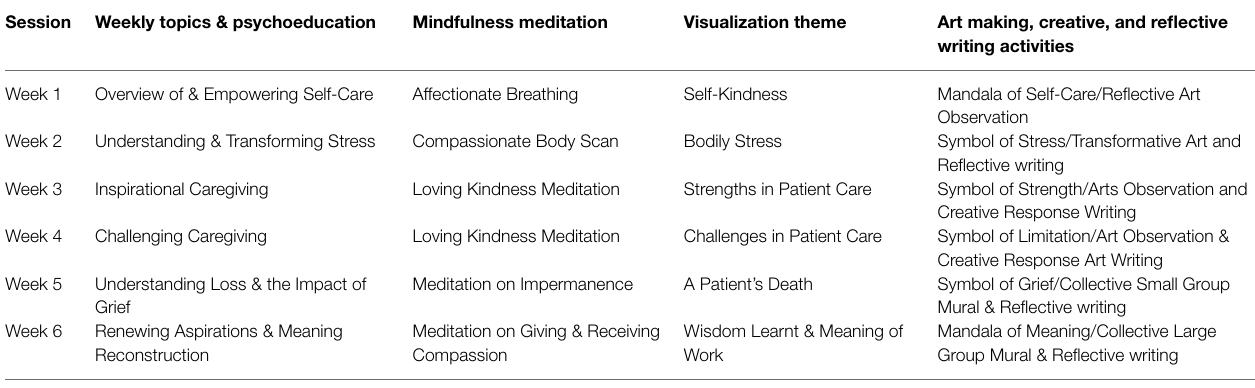
TABLE 1 | Mindful-Compassion Art-based Therapy intervention framework.